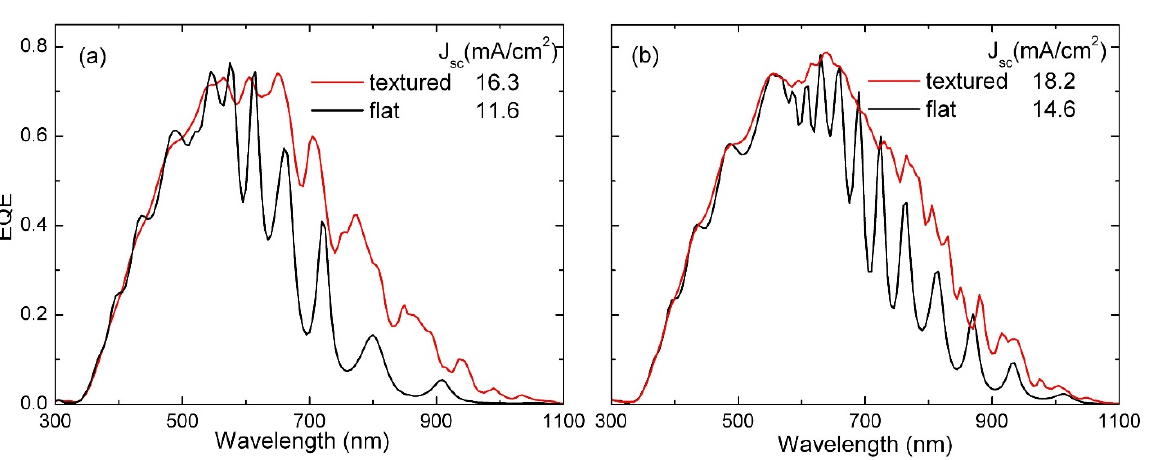
Figure 2. External quantum efficiency of identical µc-Si:H solar cells co-deposited on nanotextured (red line) and flat (black line) glass substrates, with absorber layer thicknesses of 800 nm ( a ) and 1500 nm ( b ). The short-circuit current density reported in the legend has been extracted from the EQE curve, as explained in the Materials and Methods